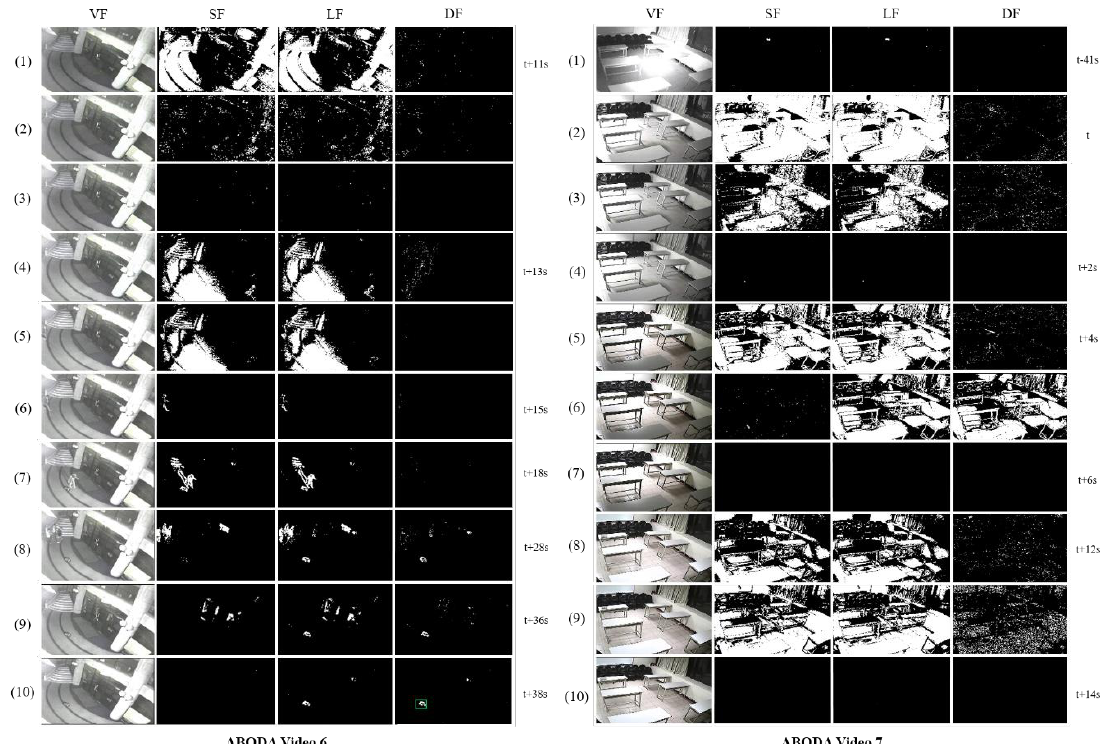
Figure 5. Illumination change handling in ABODA video 6 and video 7.